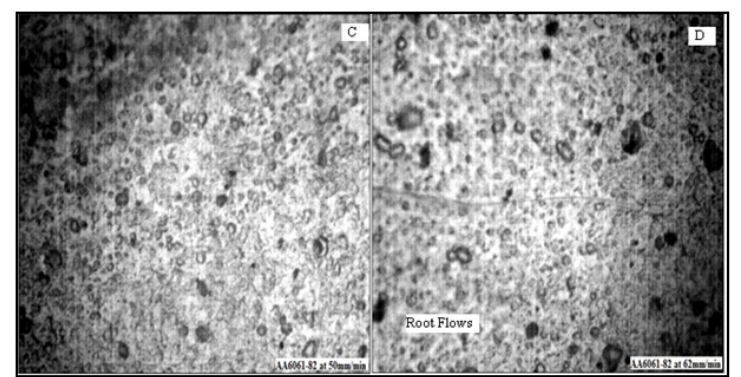
Figure 8: Optical micrograph of AA6061-6082 (C) at 50mm/min (D) at 62mm/min.